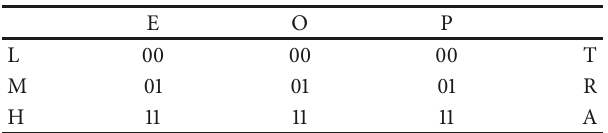
Table 2: Encoding